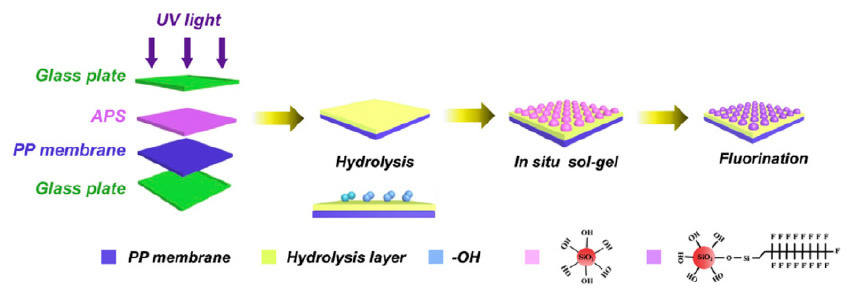
Figure 23. Schematic diagram for F/SiO 2 /PP-OH membrane preparation process (surface grafting) (reprinted from [211]).